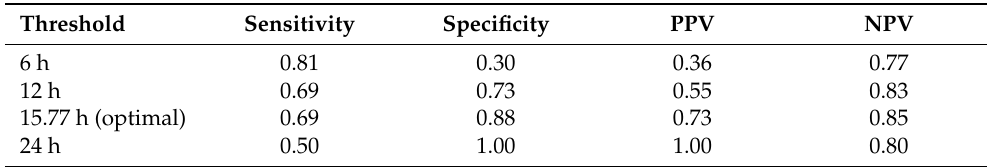
Figure 3. Box plot ( a ) and density plot ( b ) of time from injury to initial operation (hours) according to postoperative leakage following duodenal injury. Two types of surgery (primary closure alone and primary closure with pyloric exclusion) are delineated in box plot ( c ) after excluding other surgical procedures. Table 3. Predictive accuracy for postoperative leakage according to different thresholds (time from injury to initial operation) .